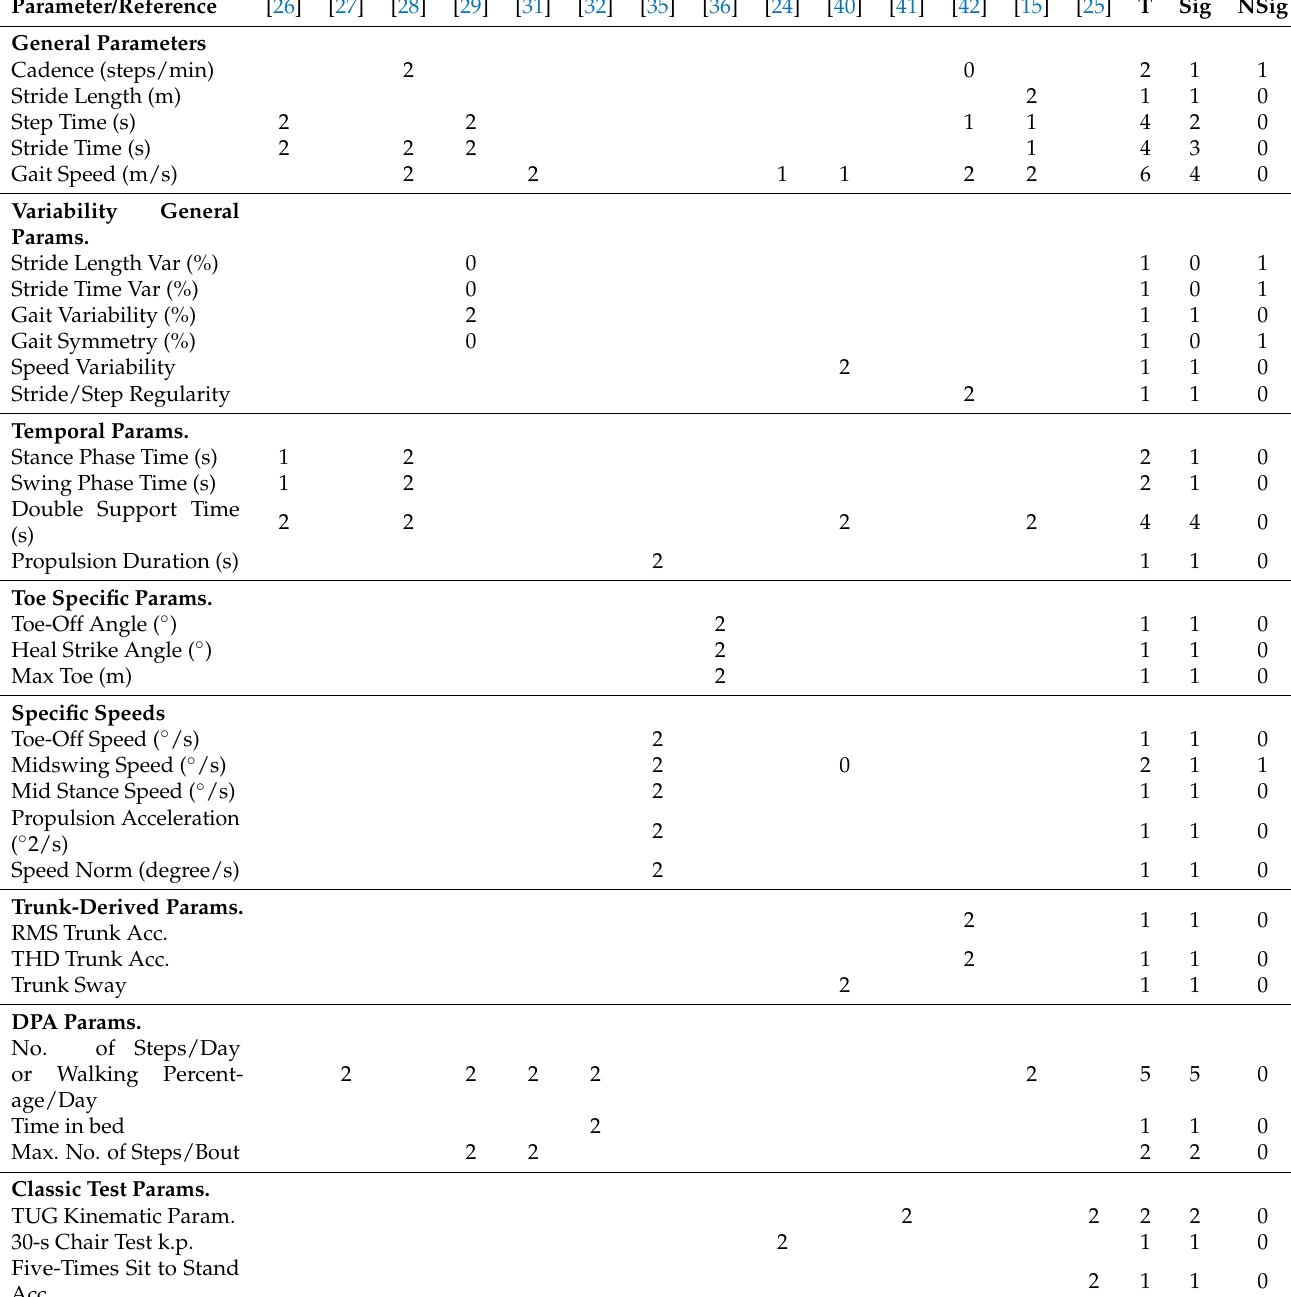
Table 4. Gait parameters related to frailty. The parameters are rated from 0 to 2 for each article, where 0: nonsignificant, 1: studied and more or less significant, and 2: significant or discriminant. T: number of total Times that each parameter was included, Sig: number of times that each parameter was considered “Significant”, and NSig: number of times that a parameter was considered as “Nonsignificant” among frailty